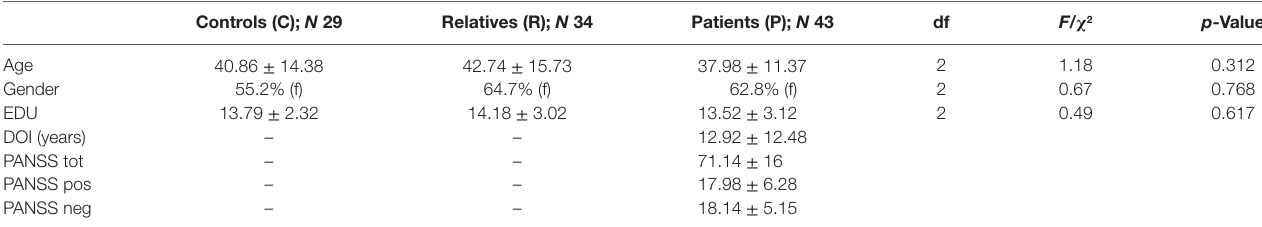
Table 1 | Demographic data and clinical status of the groups. controls (c); N